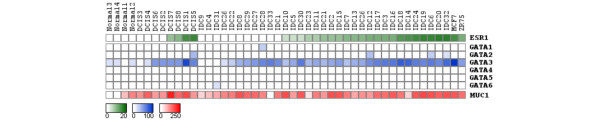
Digital northern analysis based on SAGE data of GATA family members, ESR1 and MUC1 genes in 47 breast SAGE libraries. The color scale at the bottom represents expression level based on numbers of transcripts (tags) per library. SAGE, serial analysis of gene expression.